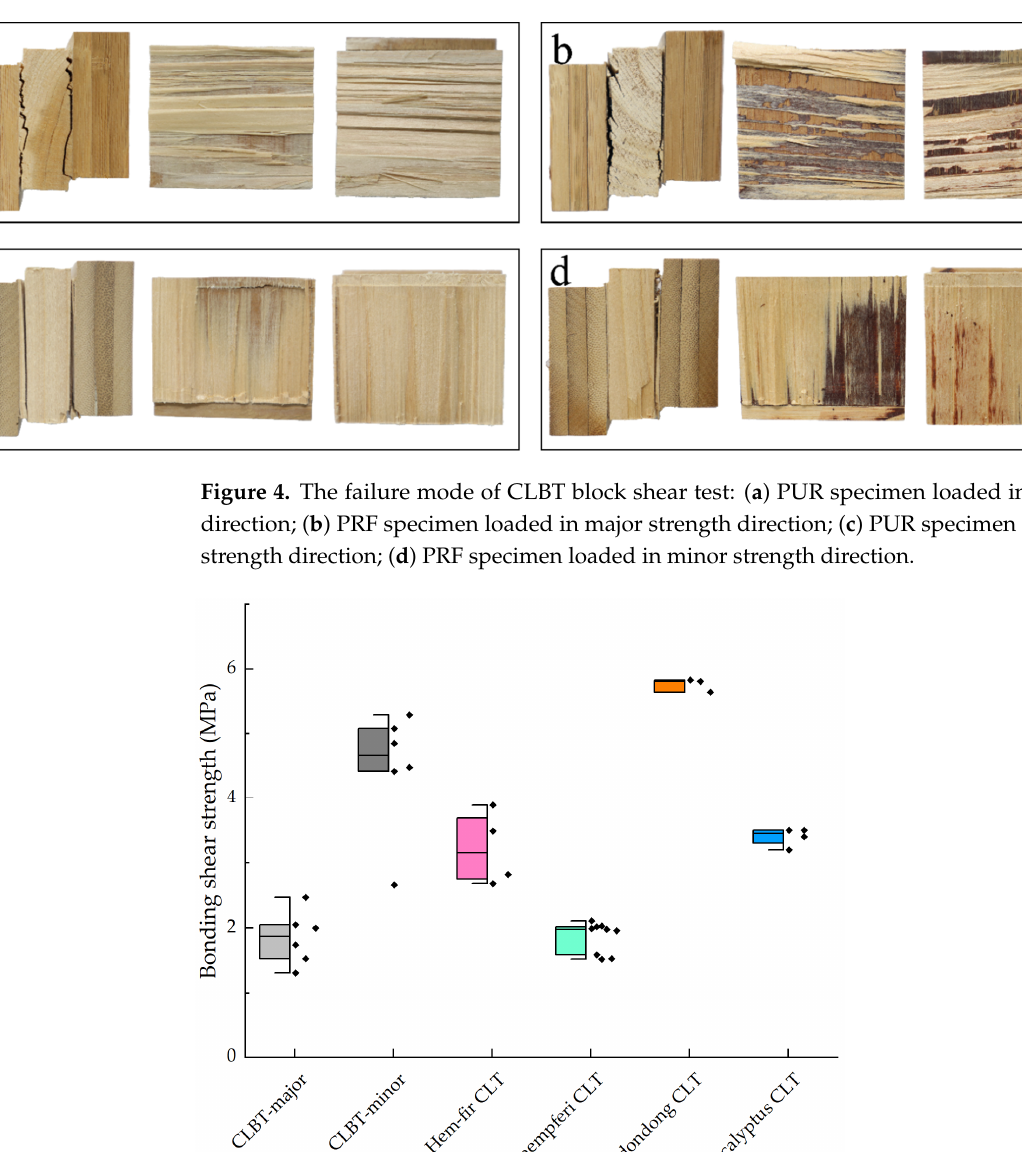
Figure 3. Bond shear properties of CLBT loaded in different directions: ( a ) bonding shear strength, ( b ) wood failure percentage.